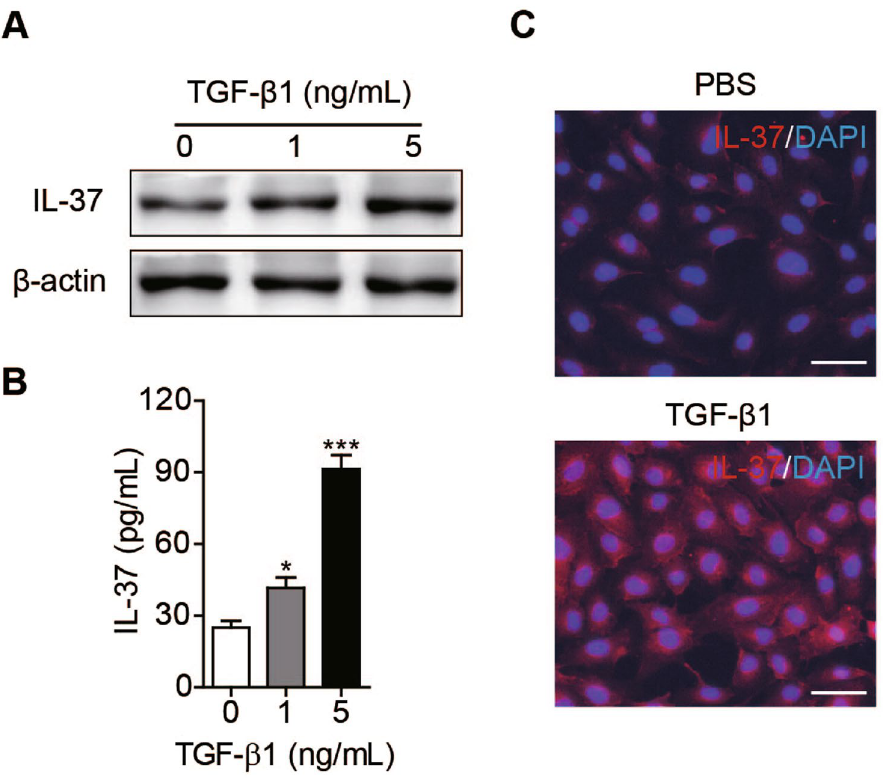
Figure 1. IL-37 expression in endothelial cells was upregulated by TGF- β . ( A ) HUVECs were pre-starved under serum-free conditions without supplemented growth factors overnight and then treated with indicated concentrations of TGF- β 1 for 12 hours. IL-37 expression was examined by Western blot. Blots are representative of three experimental replicates. ( B ) Quantification of IL-37 in the supernatants of HUVECs when treated with indicated concentrations of TGF- β 1 determined by ELISA. n = 4 per group. ( C ) Immunofluorescent staining of cultured HUVECs for IL-37 after treated with PBS or TGF- β 1. Scale bar, 50 μ m. Data are presented as mean ± SEM ( n = 4 per group). * P < 0.05. ** P <